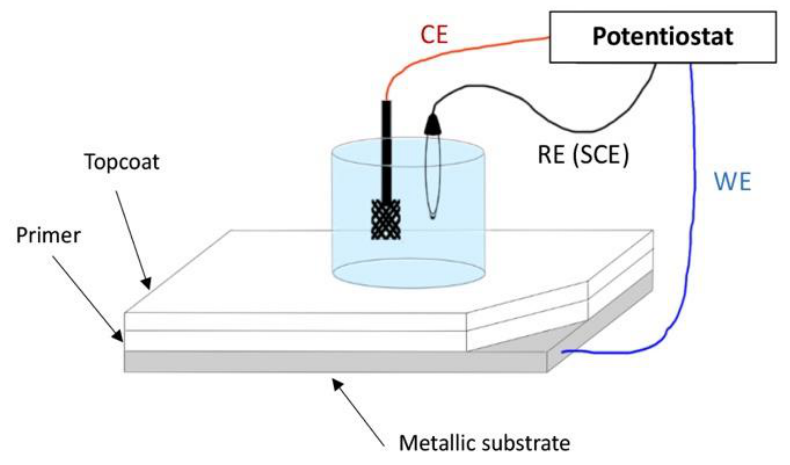
Figure 2. A scheme of the traditional benchtop EIS configuration and setup (personal drawing; inspiration from [73,74]).